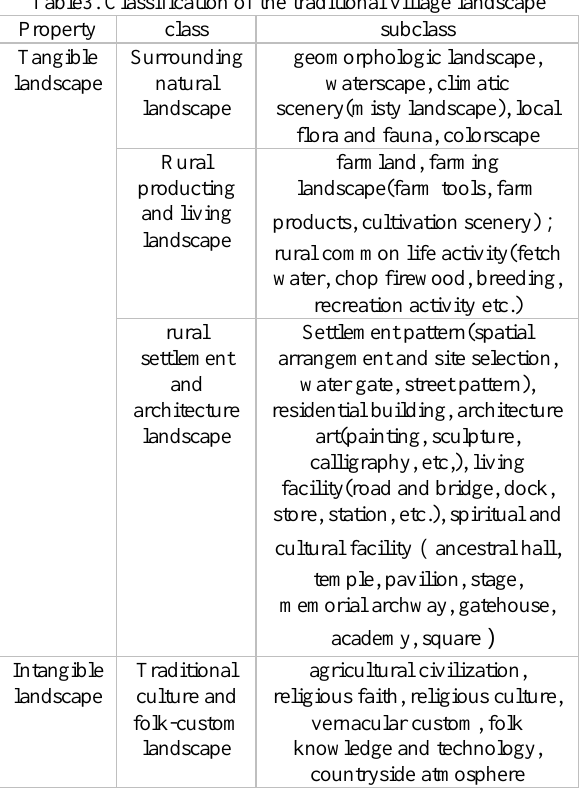
Table3. Classification of the traditional village landscape